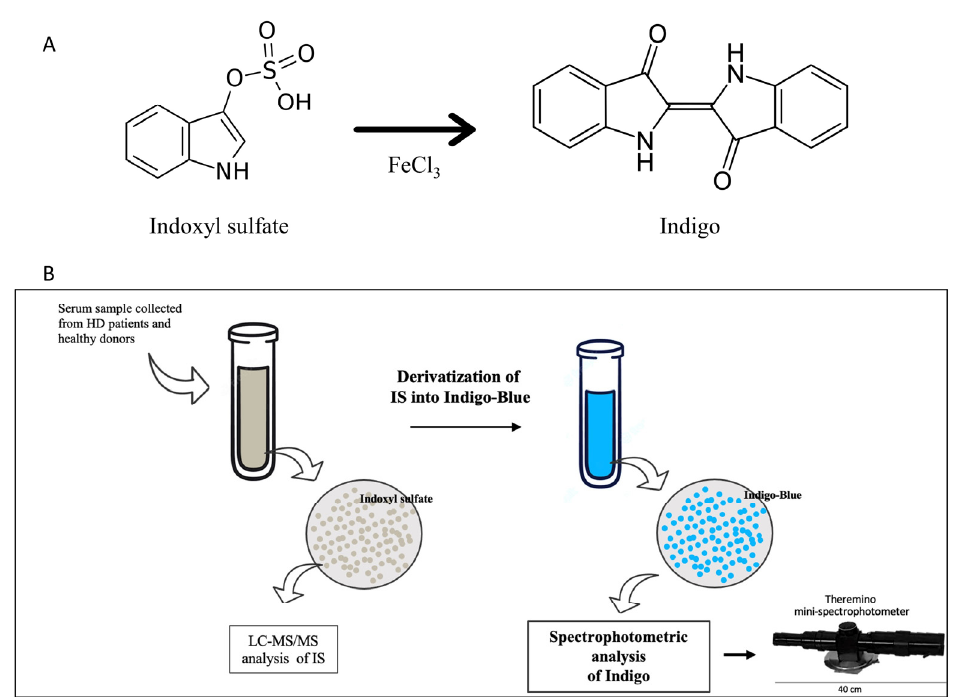
Figure 1. ( A ) Process of IS conversion into Indigo. IS-derived Indigo is a chromophore that could be detected in UV-VIS mode by spectrophotometric analysis (Theremino) and LC-MS/MS. ( B ) Experimental design. Firstly, the total concentration of IS in serum was investigated by tandem mass spectrometry. Next, the whole fraction of IS in each sample was converted into Indigo by derivatization. Finally, the concentration of Indigo was detected by spectrophotometry using the mini-spectrophotometer